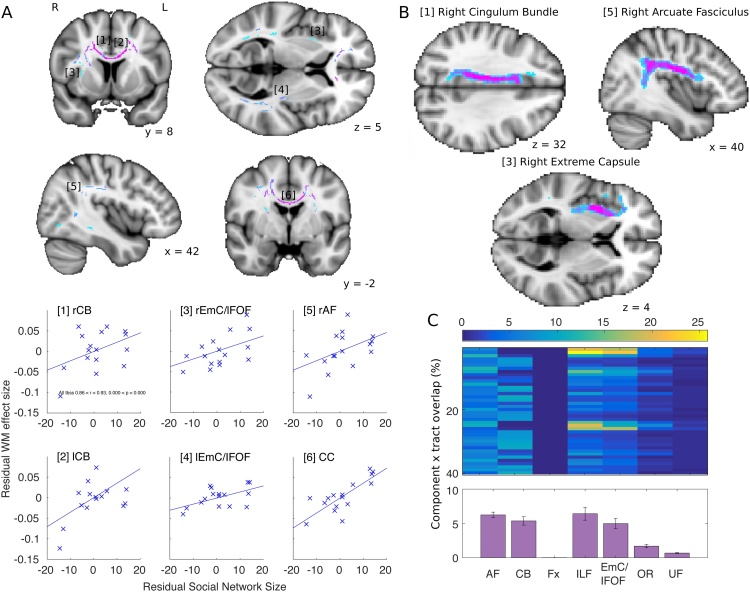
[A] TBSS results showing fiber pathways (purple-turquoise colors tfce corrected p < 0.05) in which FA correlates with SNS. For illustrative purposes we show the relationships between residual SNS and the mean FA value extracted from ROIs masks positioned in identifiable white matter tracts. [B] Tractography results from 3 probablistic tractography investigations seeded in the subsections of white matter identified in A; [1] right cingulum bundle, [3] right extreme capsule and [5] right arcute fasciculus. Visual thresholds set ≥9–17 subjects. Intensity from turquoise to purple represents number of subject’s with overlapping tracts. Images are in radiological convention. [C] Percentage overlap between components from the tractography decomposition analysis and published WM tracts from the NatBrainLab. Bar plot shows mean percentage overlap and between component standard error. Abbreviations: CB cingulum bundle, EmC/lFOF extreme capsule / inferior fronto-occipital fasciculus, AF arcute fasciculus, CC corpus callosum, Fx fornix, ILF inferior longitudinal fasciculus, OR optic radiations, UF uncinate fasciculus. (For interpretation of the references to colour in this figure legend, the reader is referred to the web version of this article).